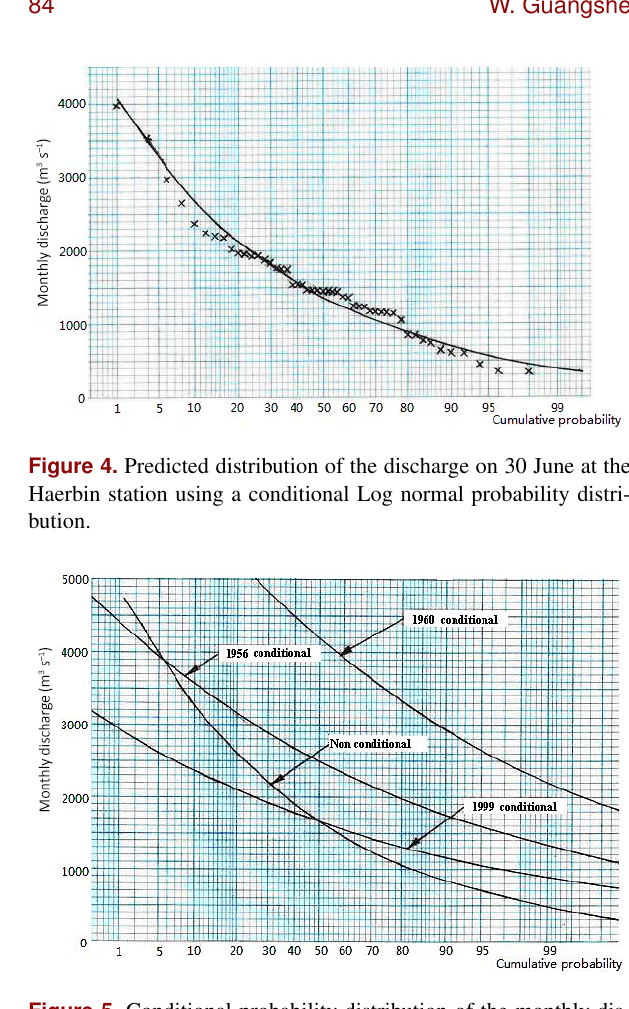
Figure 5. Conditional probability distribution of the monthly dis- charge of July for several years and the non-conditional distribution at the Haerbin